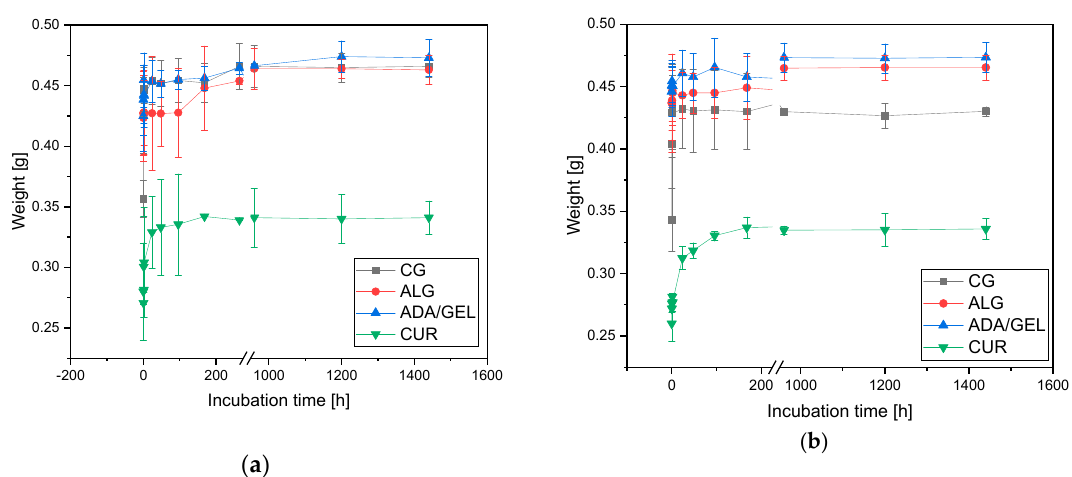
Figure 6. Weight development over the duration of the experiment; ( a ): incubation in TRIS pH 5.0, ( b ): incubation in TRIS pH 7.4; CG . . . control group = empty RMS; ALG . . . RMS + Alginate; ADA/gelatin . . . RMS + ADA/gelatin; CUR . . . empty Curasan.